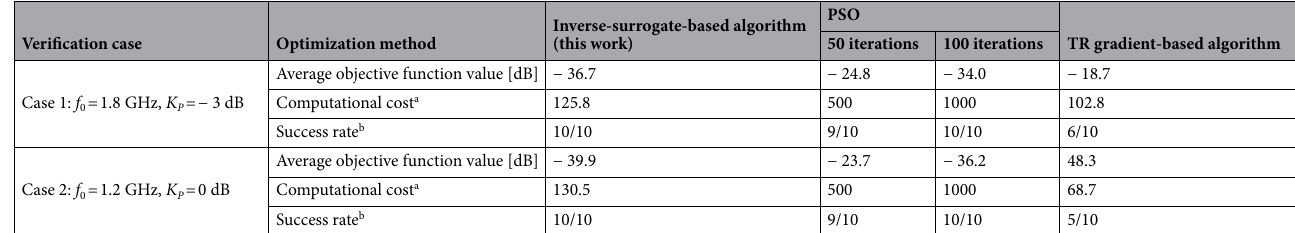
Table 4. Circuit I: optimization results. a The cost expressed in terms of the number of EM simulations of the antenna structure under design. b Number of algorithms runs at which the operating parameters were allocated to satisfy the condition D ( F ( x *), f t ) ≤ D accept